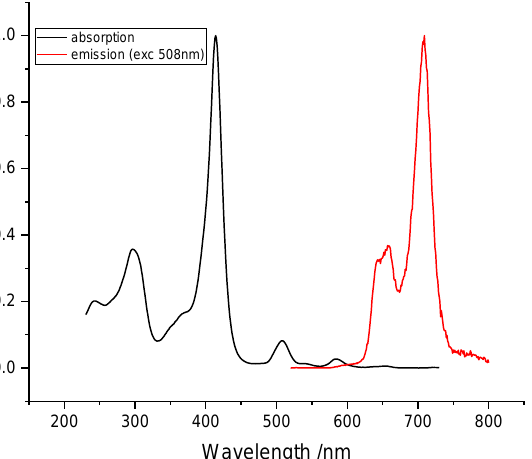
Figure 3. Absorption and fluorescence spectra of Dyad 1 in ethanol (See ESI for detailed exp. condi- tions).